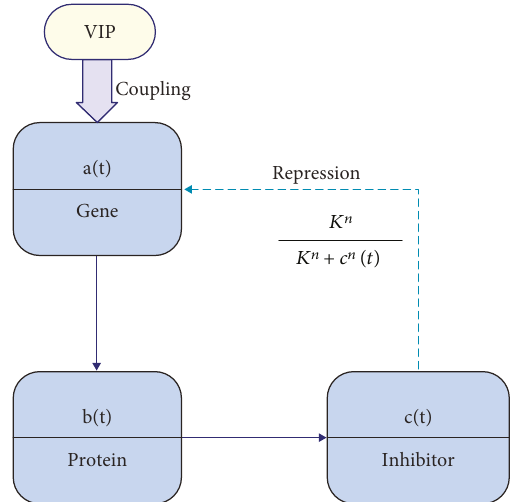
Figure 1: Scheme of a circadian oscillator modeled by a Goodwin oscillator. By the repression exerted by the inhibitor (c (t)) to the clock gene mRNA synthesis (a (t)), the three variables build up a closed negative feedback loop. The coupling from vasoactive intestinal polypeptide (VIP) is required to maintain circadian synchrony of the circadian